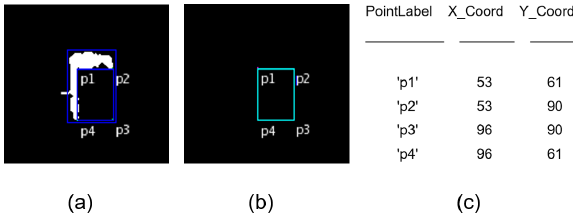
Figure 4. The documentation of the buildings. (a) the creation of the two bounding boxes (inner and outer), (b) the identification of the building edges (shape), and (c) the extraction of the graphic coordinates of the